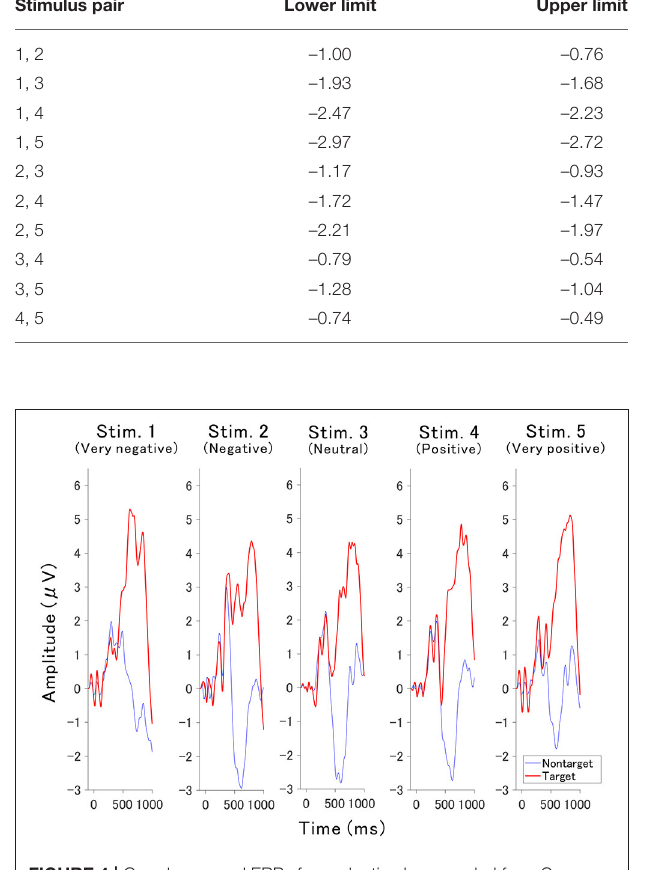
FIGURE 5 | Contribution of each feature to the classification accuracy. This contribution was estimated based on r 2 values.